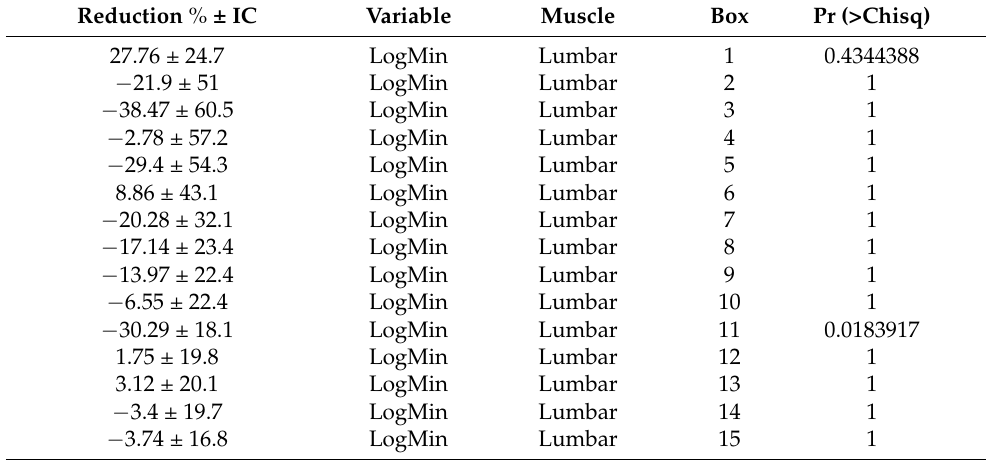
Table A6. The first column includes the percentile of reduction with the confidence interval. The second column shows the variable, in this case, the LogMin; the third column, the muscle; and the fourth column, the number of box. Last value contains the p -value of the